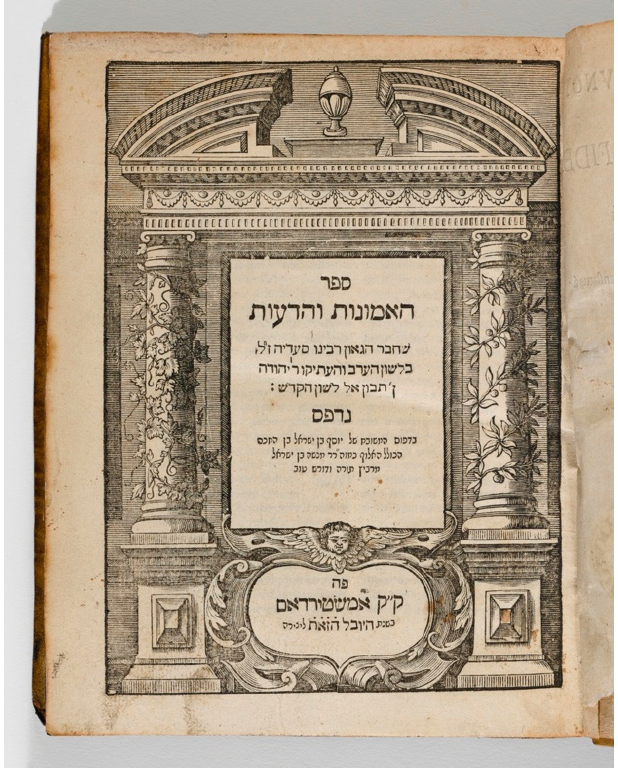
Figure 16. Sefer emunot ve-de’ot (The Book of Beliefs and Opinions); Marsh’s Library B.3.4.9.